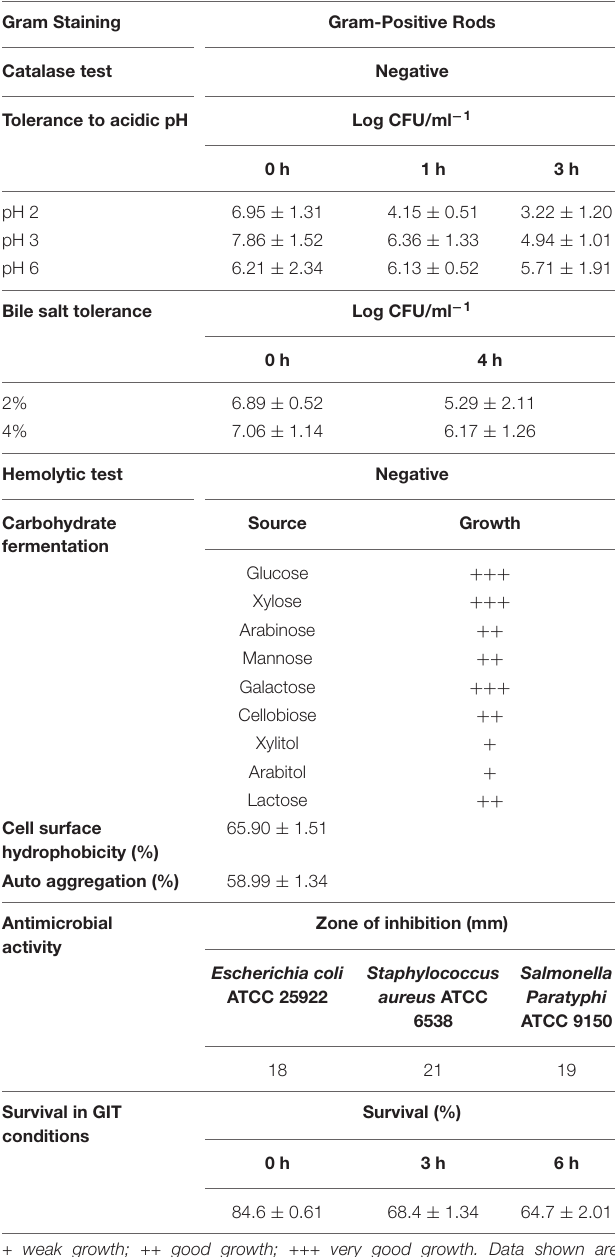
TABLE 1 | Characterization of the isolate MYSN105 from fermented food